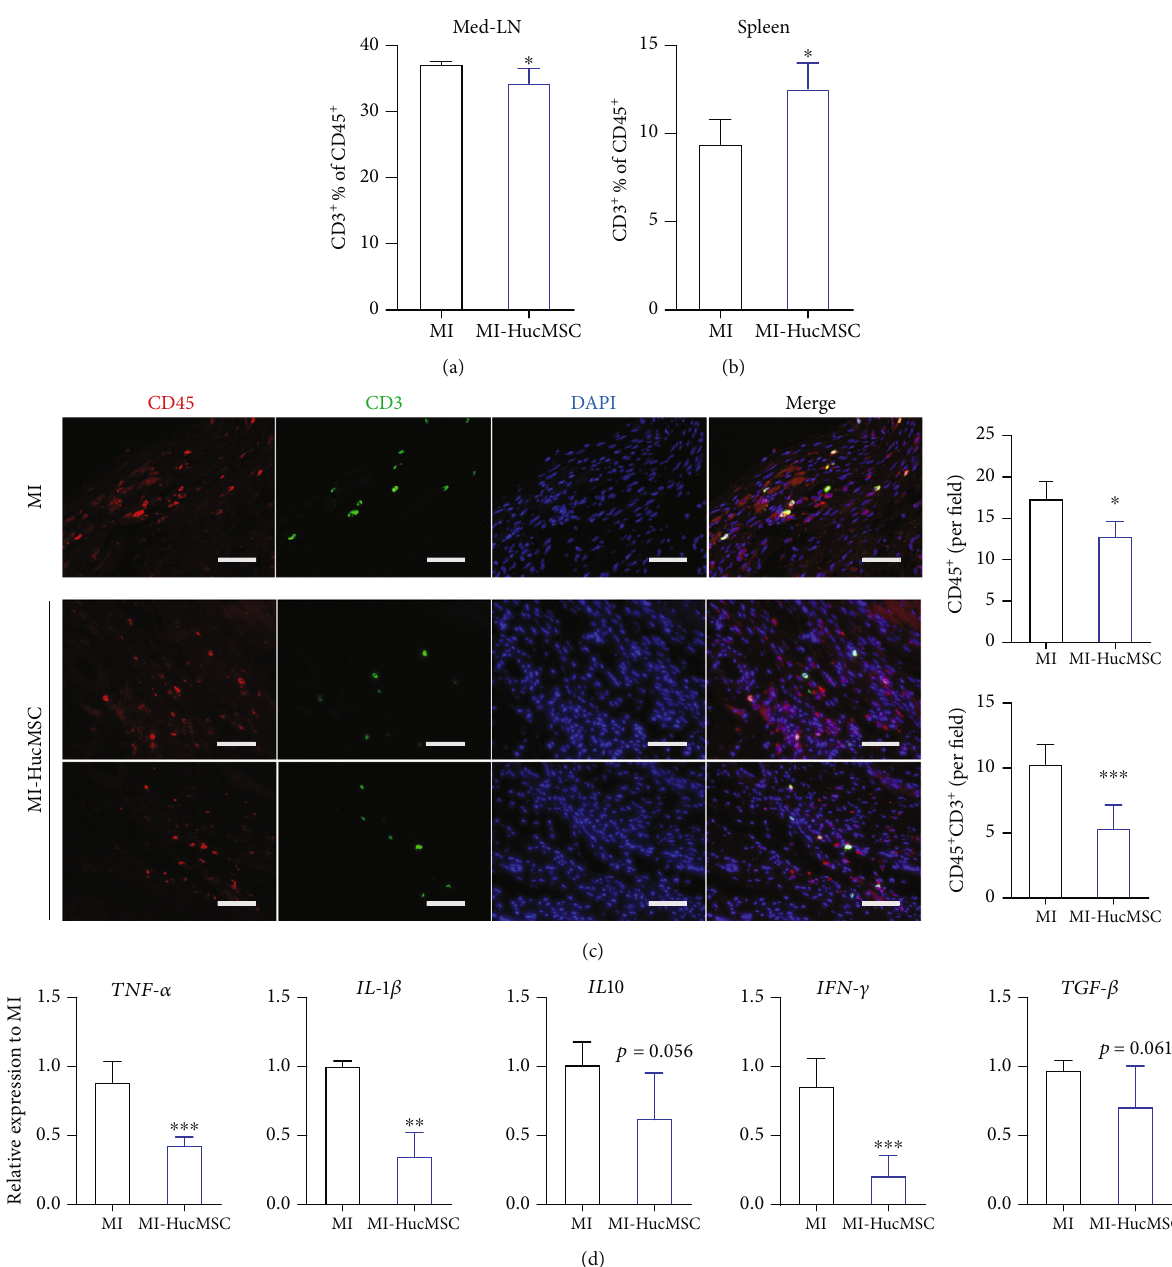
Figure 5: Long-term immunomodulatory e ff ects of iv-administered HucMSC in vivo. (a) Flow cytometry analysis of T cells (CD3 + % of CD45 + ) in the med-LNs. n = 3 ~ 4 mice for each group. (b) Flow cytometry analysis of T cells (CD3 + % of CD45 + ) in the spleen. n = 3 ~ 4 mice for each group. (c) Representative images and quantitative analysis of CD45 + immune cells and CD45 + CD3 + T cells in the peri- infarct area at 21-day post-MI. n = 5~ 6 mice for each group. Scale bar = 100 μ m. (d) qRT-PCR measurement of in fl ammatory cytokines in the infarcted heart. n = 5~ 6 mice for each group. ∗ p < 0 : 05 vs. MI group; ∗∗ p < 0 : 01 vs. MI group; ∗∗∗ p < 0 : 001 vs. MI